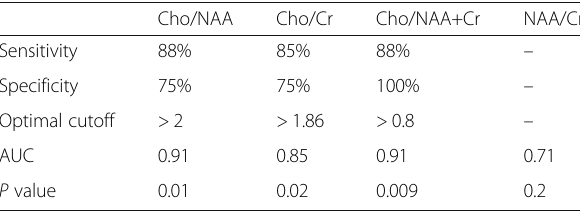
Table 2 ROC curve analysis of the various metabolite ratios for the prediction of neoplastic lesions